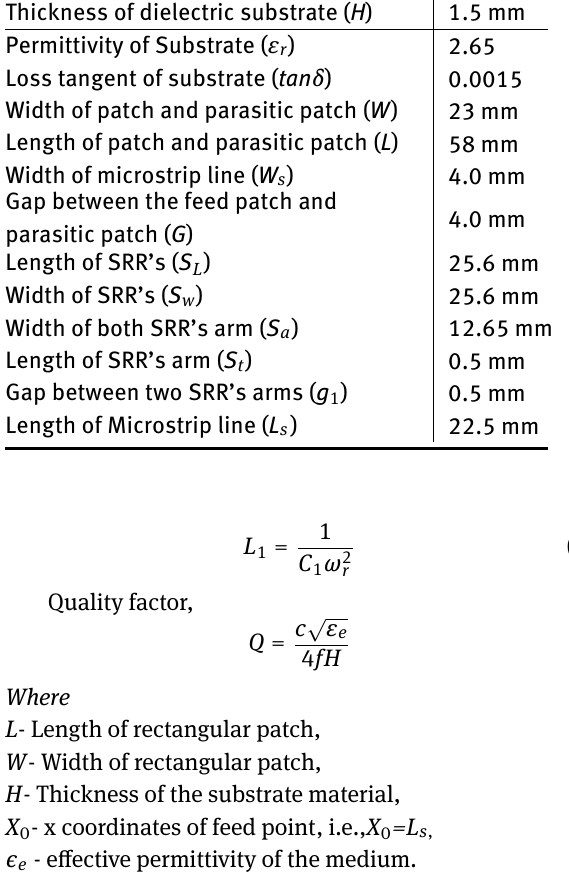
Table 1: Design specifications of microstrip line feed patch anten- nasare given